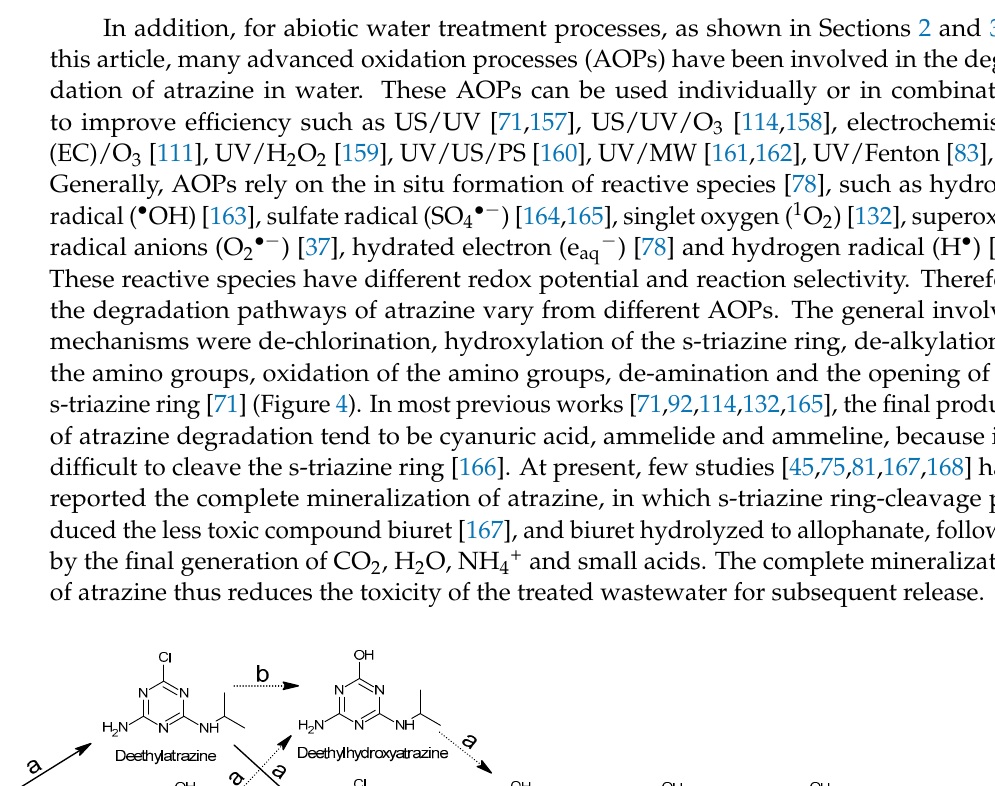
Figure 3. Degradation pathway of atrazine through biotic treatment process.